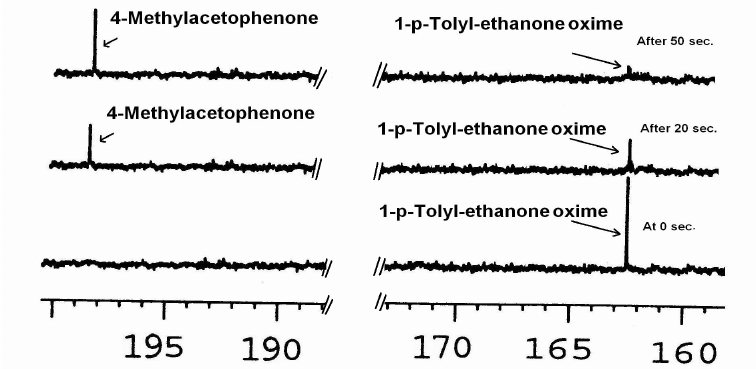
Figure 1. Progress of a typical reaction as monitored by 13 C{ 1 H} NMR analysis at different time intervals for entry